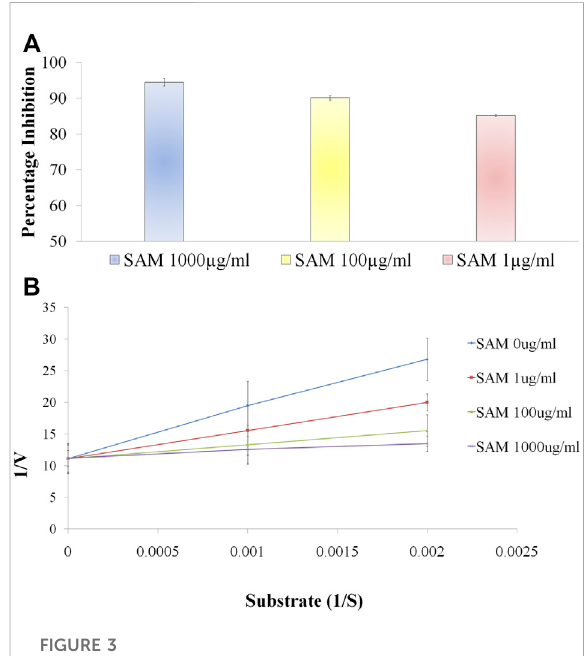
FIGURE 3 S. apetala fruit extract (SAM) inhibits human neutrophil elastase in situ (A) Enzyme inhibitory activity of various concentrations of SAM against Human Neutrophil Elastase. Enzyme inhibition assay was performed using Human neutrophil elastase incubated with SAM (1 μ g/ml, 10 μ g/ml and 100 μ g/ml) to evaluate the percentage inhibition of the extract. (B) Enzyme kinetics to ascertain the mechanism of action of SAM on neutrophil elastase. Substrate titration of steady-state rate of HNE in the presence of SAM Data is presented in double reciprocal format. Data is represented from three independent experiments ( n = 3).